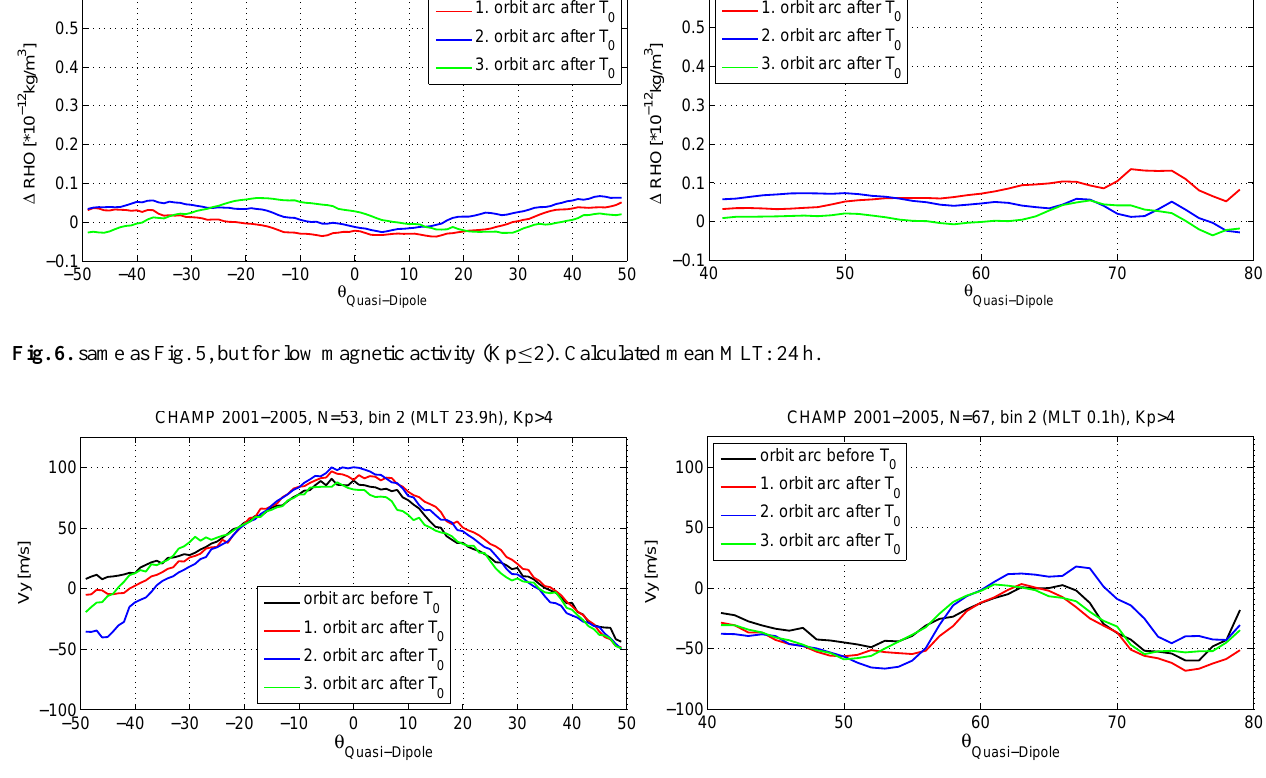
Fig. 7. Mean thermospheric wind velocity at low (left frame) and high (right frame) latitudes for Kp > 4 of data subsets in bin 2. Black line: orbit arc before substorm onset T 0 ; red line: 0.25-1.25h after substorm onset T 0 ; blue line: 1.75–2.75h after T 0 ; green line: 3.25–4.25h after T 0 . Calculated mean MLT: 24h. The mean uncertainty of the zonal wind curves is ± 15m/s.